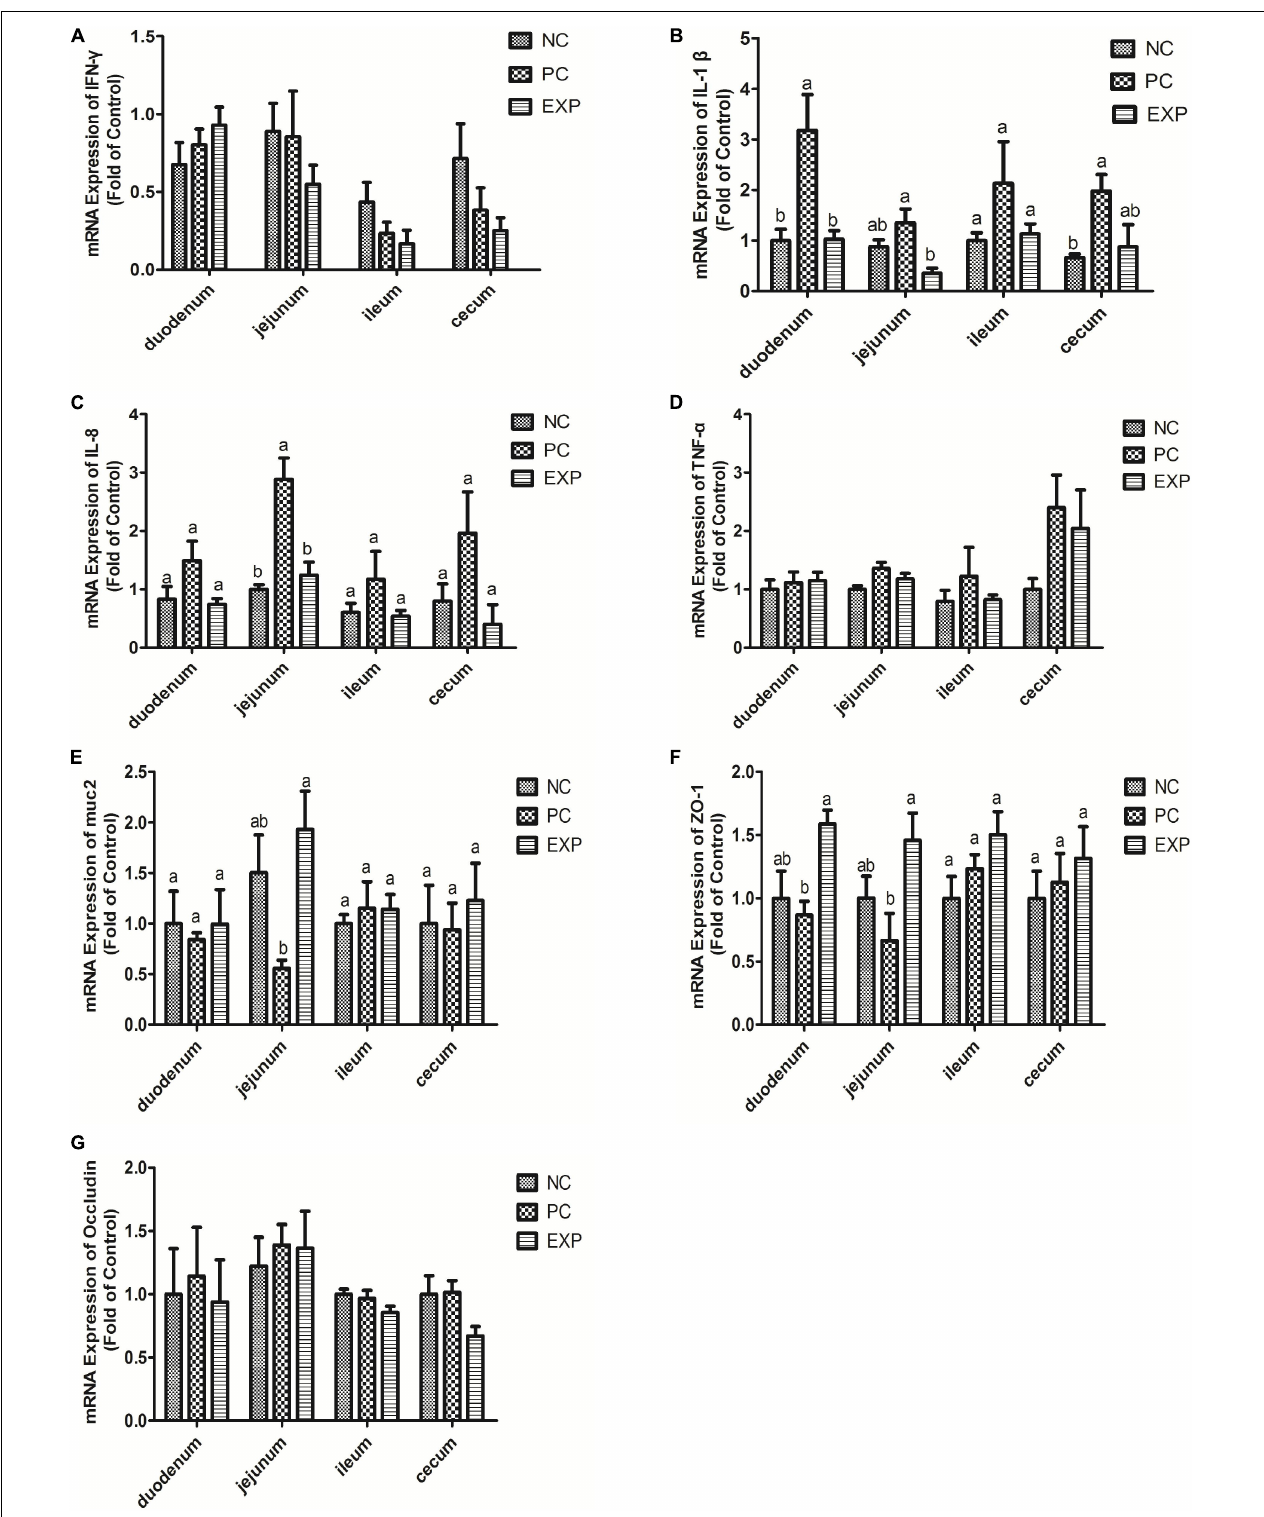
FIGURE 2 | Expression level of cytokines (IFN- γ , IL-1 β , IL-8, and TNF- α ), muc2 mucin and the tight junction proteins (ZO-1 and Occludin) (A–G) in intestine tissues (duodenum, jejunum, ileum, and cecum) were estimated by real-time PCR. The bars represent the mean ± SD ( n = 6/group). Different letters over the bars indicate statistically differences between the groups ( P < 0.05), same letters over the bars indicate no statistically differences between the groups ( P > 0.05). NC, the negative control group; PC, the positive control group; EXP, C. butyricum + S. enteritidis treatment.